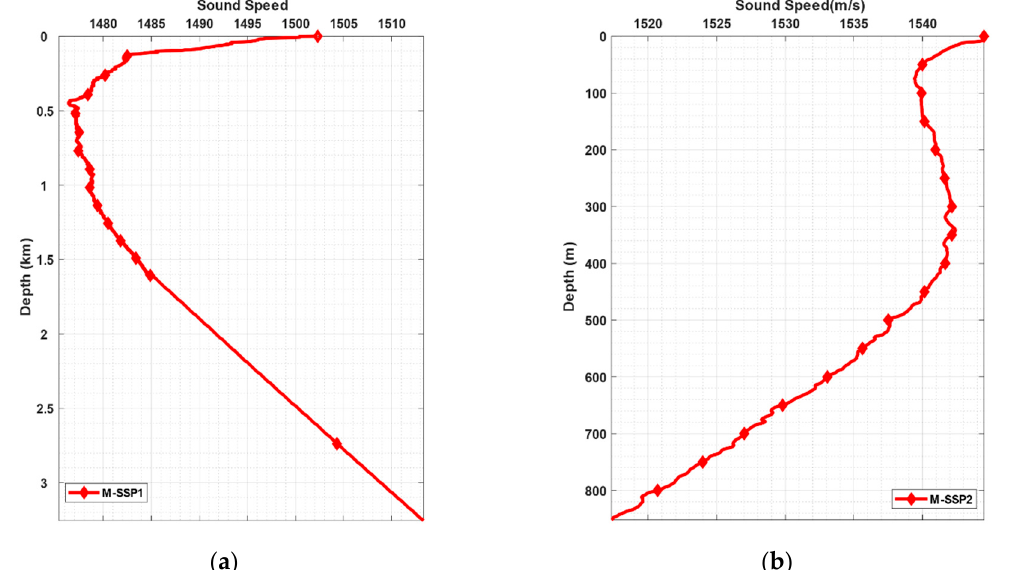
Figure 11. The (Sound Speed Profiles) (SSP) extracted from World Oceanic Database (WOD) database with part ( a ) showing the first SSP (labeled M-SSP1) measured at coordinate of N40° 31' 24.179'' W127° 35' 52.27'', and ( b ) signifies the second SSP (labeled M-SSP2) measured at N20° 7' 18.0624'' W 175° 56' 17.3436''.